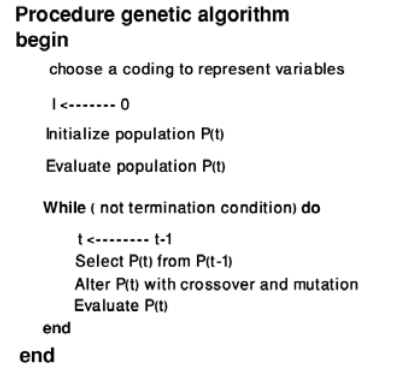
Fig1. Simple genetic algorithm